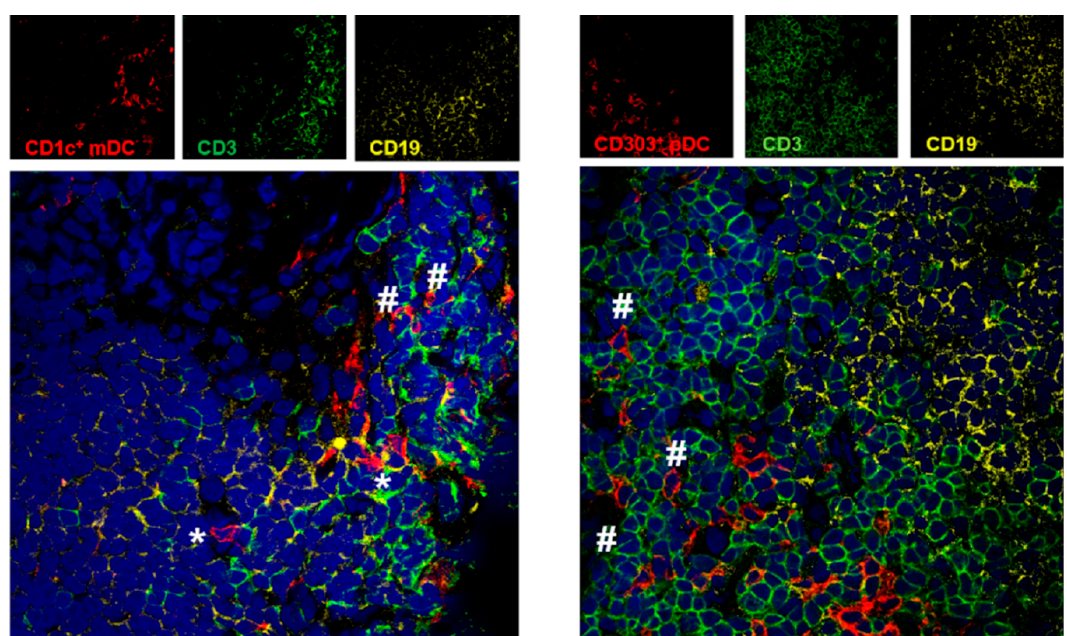
Figure 3. Localization of mDCs and pDCs in human lymphoid tissue. Lymph node tissue sections from a healthy control ( A ), RA-risk individual ( B ) and RA patient ( C ) stained for mDCs (left panels) and pDCs (right panels) using BDCA1 or BDCA2 antibodies (indicated in red). CD19+ B cell areas are indicated in yellow and CD3 + T cell areas are indicated in green. In 63x zoom images # represent DCs in close proximity to T cells. * represents DCs in close proximity to B cells.